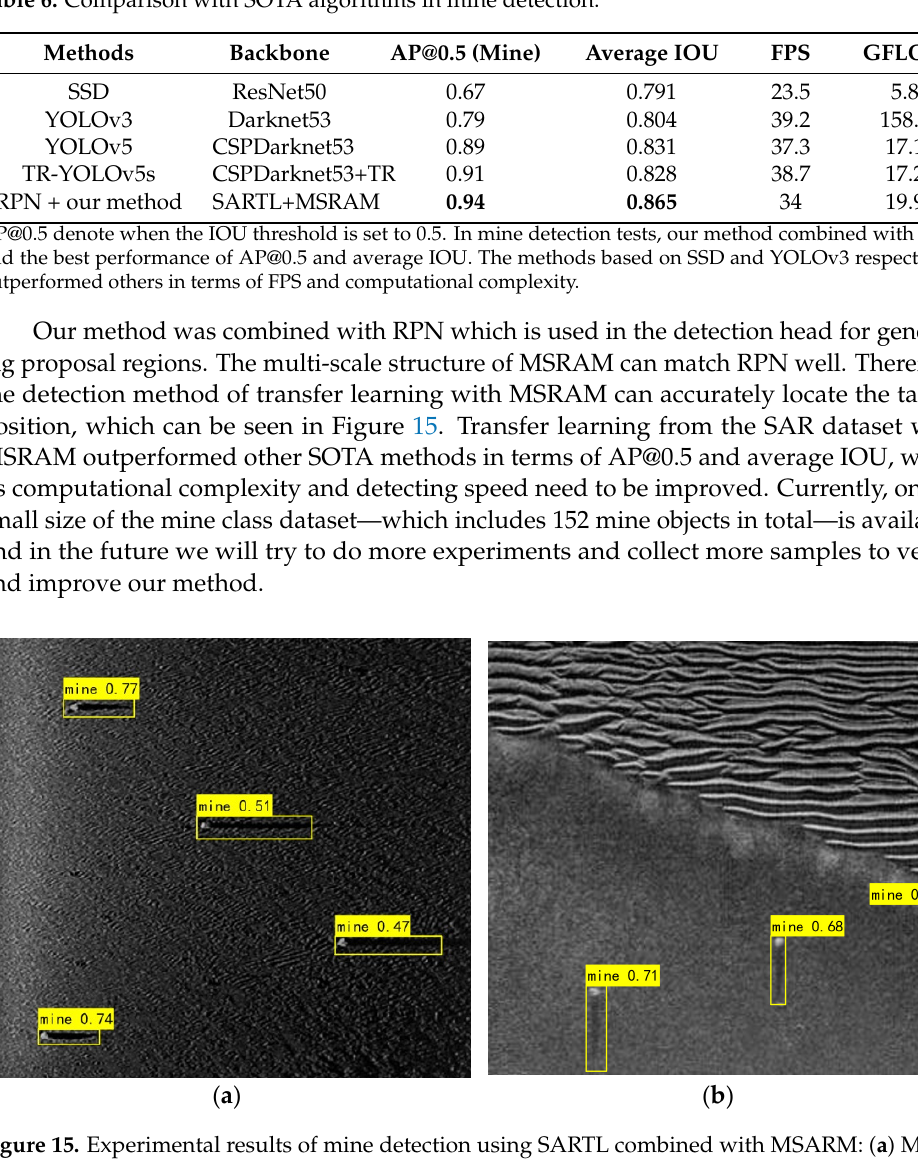
Table 6. Comparison with SOTA algorithms in mine detection.